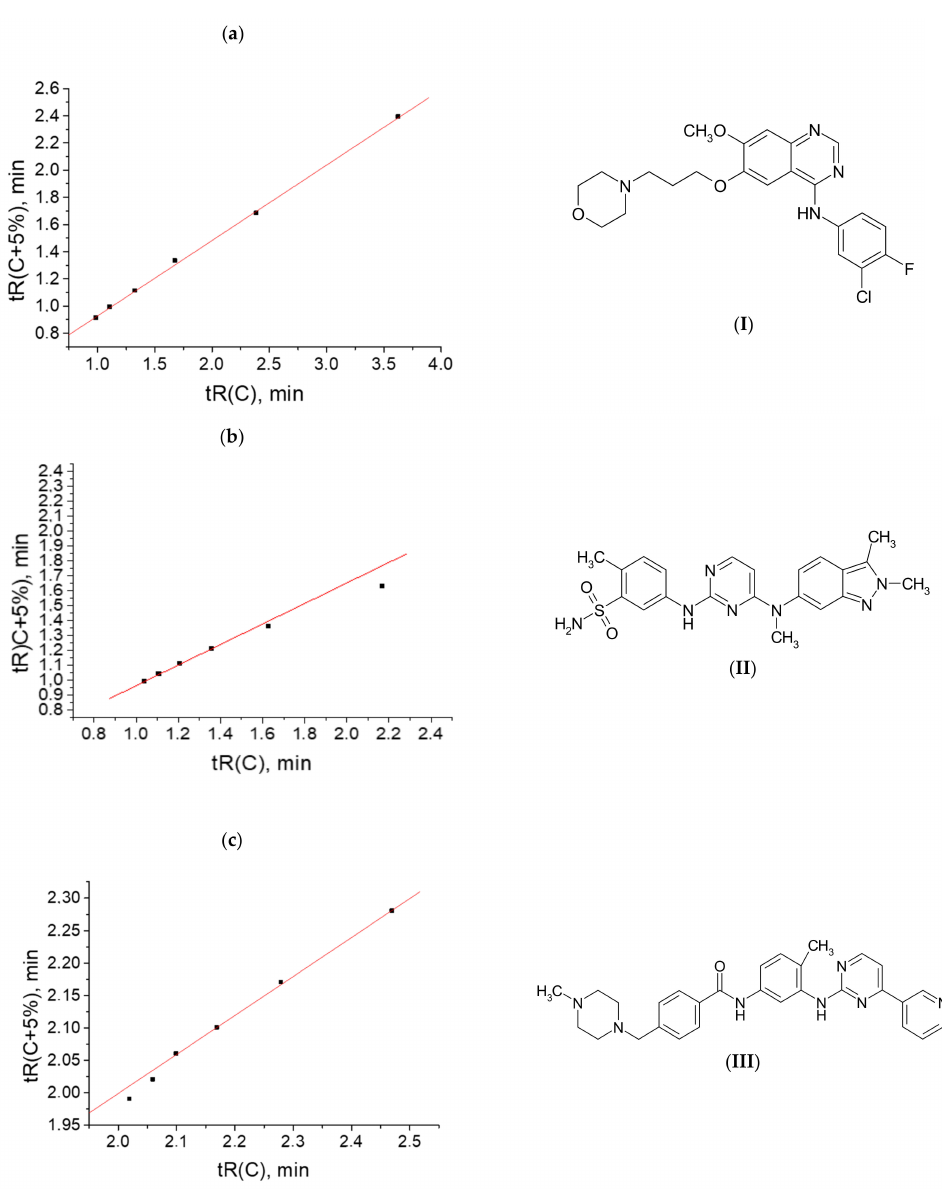
Figure 1. Examples of some of the typical features in the recurrent approximation plots of the retention times of ( a ) gefitinib ( I ), ( b ) pazopanib ( II ), and ( c ) imatinib ( III ); all data were obtained with acetonitrile–water eluents. See text for detailed